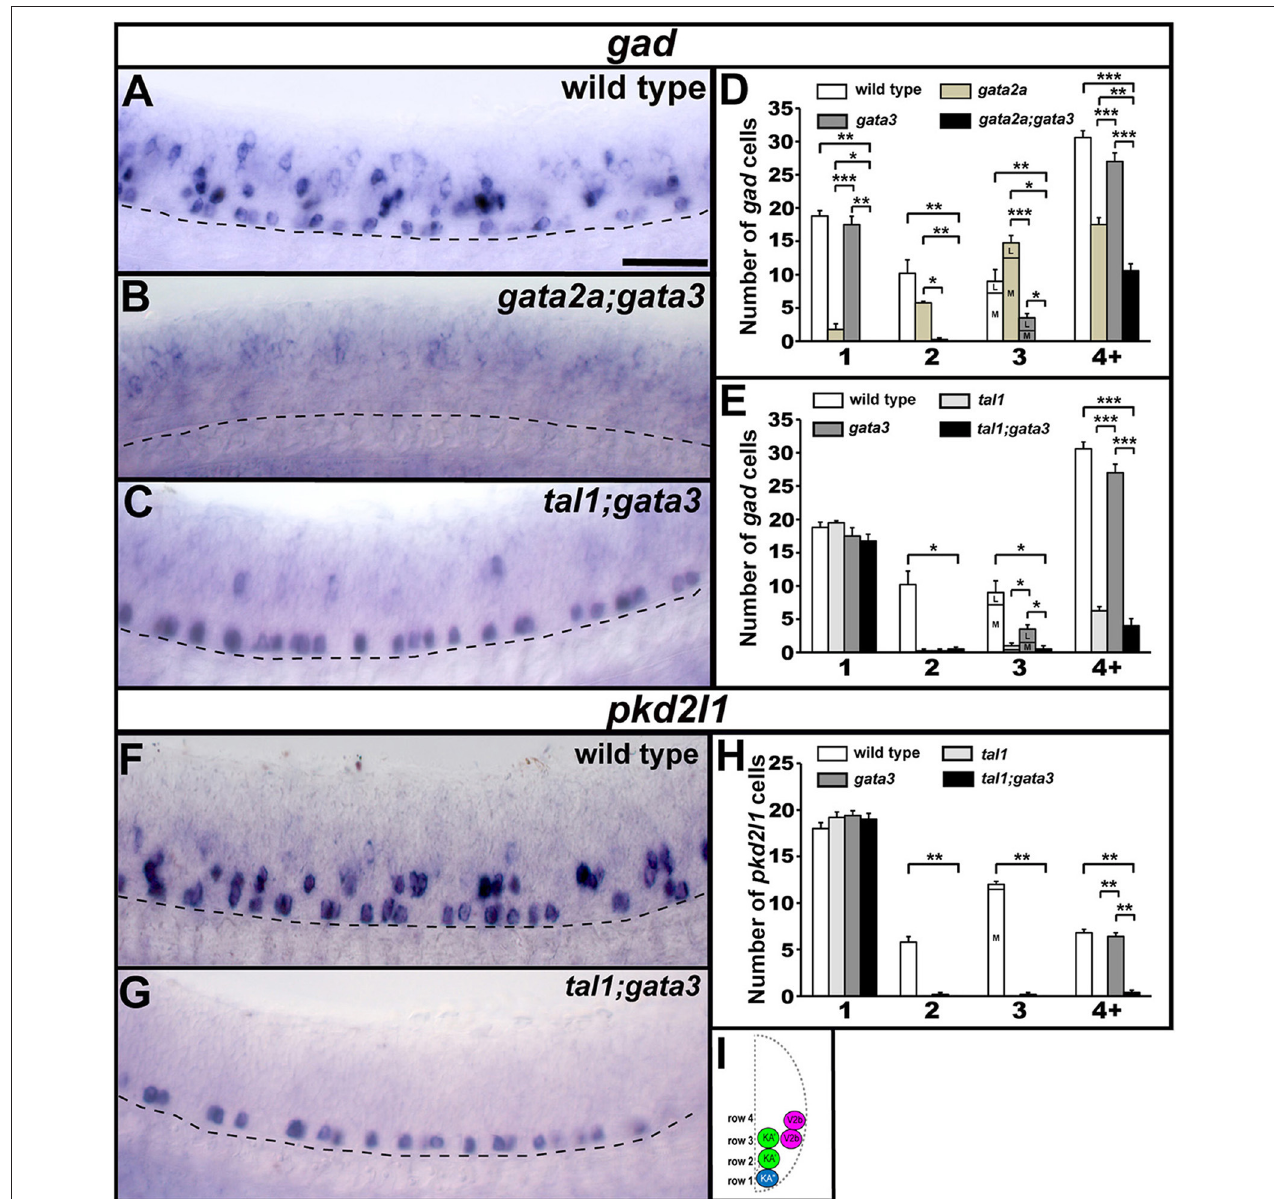
FIGURE 10 | gad and pkd2l1 expression in double mutant embryos. Lateral views of gad (A–C) or pkd2l1 (F,G) expression in 24h WT sibling and double mutant embryos as indicated. Dorsal, top; anterior, left. Scale bar = 50 microns. Dashed lines indicate ventral limit of spinal cord. The approximate proportions of medial and lateral row 3 cells are indicated by horizontal lines separating the number of medially-located cells (bottom and indicated where there is space with an “M”) from the number of laterally-located cells (top and indicated where there is space with a “L”). Mean number of cells expressing gad or pkd2l1 in each D/V row of precisely-defined spinal cord region adjacent to somites 6–10 in WT and single and double mutant embryos (D,E,H) . All counts are an average of at least 4 embryos. Error bars indicate SEM. Statistically significant comparisons are indicated with brackets and stars. *** P < 0.001, ** P < 0.01, * P < 0.05. In (E) , there is no statistically significant difference between any row 1 values or between tal1 single mutants and tal1;gata3 double mutants in row 4 + . In (H) , there is no statistically significant difference between any row 1 values. For P- values see Supplementary Table 3. Cross-sectional schematic indicating positions of KA ′′ , KA ′ , and V2b neurons (I)